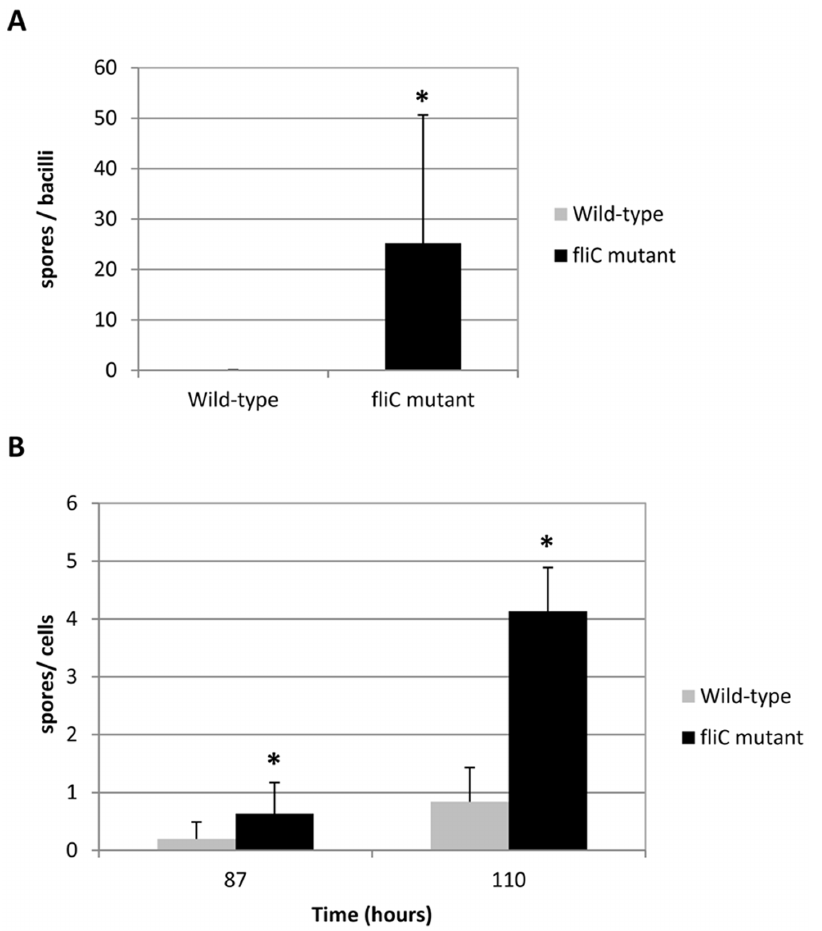
Figure 2. Ability of sporulation of the fliC mutant compared to wild-type R20291 invivo and invitro . ( A ) Groups of 6 axenic mice were infected by oral gavage route with 1 6 10 8 C. difficile CFU. The C. difficile faecal vegetative cells and spores were measured by determining the concentration of CFU in faeces at 14 h post-infection by homogenising and plating on appropriated agar medium after heat shock (for spores) or not (Materials and Methods). Data represent the ratio of spores per vegetative cells. ( B ) Cultures in BHIS broth in anaerobic conditions were prepared from 2 successive subcultures as indicated in Materials and Methods. After heat shock, spores were quantified (CFU/ml) by performing serial dilutions and spread plating on BHIS agar supplemented with 0.1% bile salt taurocholate to induce germination. Data represent the ratio of spores per total cells. The presented values are the mean of 3 different cultures. Statistically significant difference is indicated by * for p , 0,05.